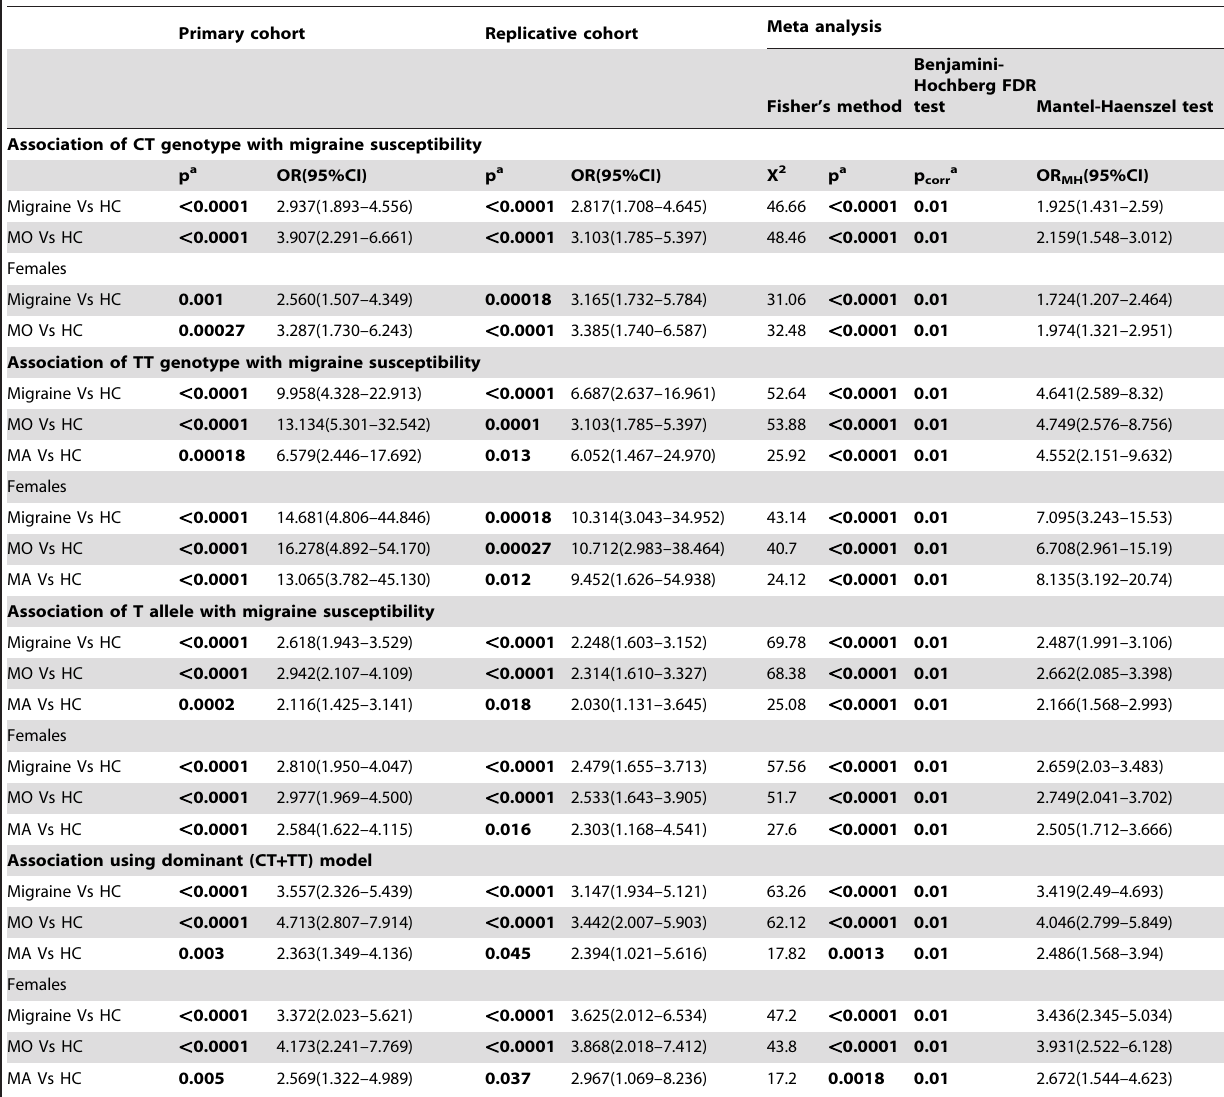
Table 1. Association study of CYP19A1 rs10046